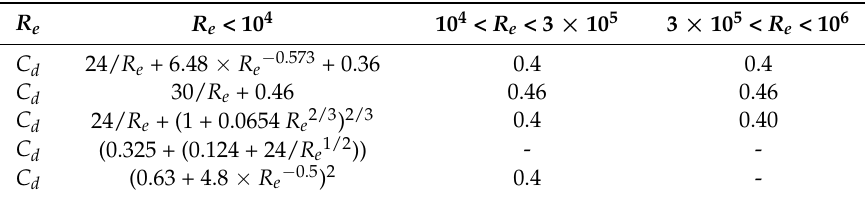
Table 2. Relationship between Reynolds number and drag coefficient for the